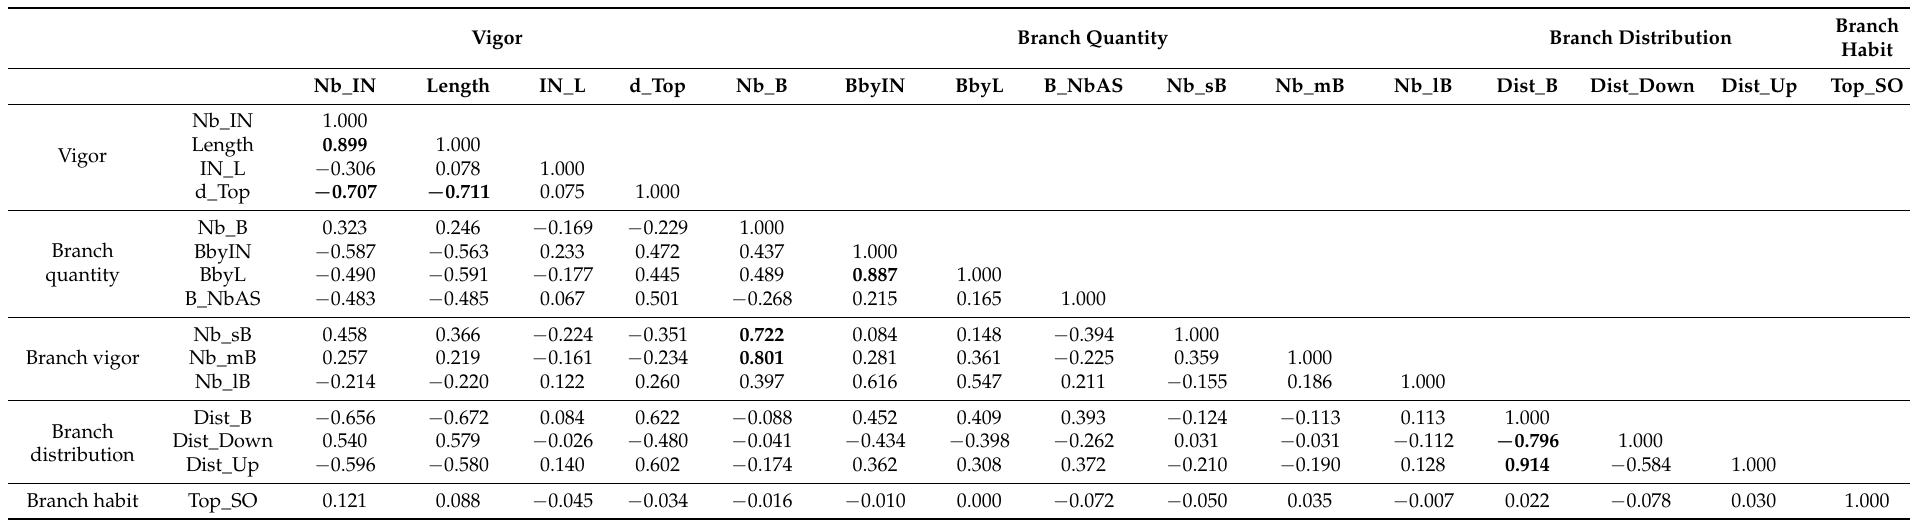
Table 3. Pearson’s correlation coefficients of variables comparing 30 almond scion–rootstock combinations, classified by which aspect of almond tree architecture they affect and selected by rootstock influence. Refer to Table 1 for